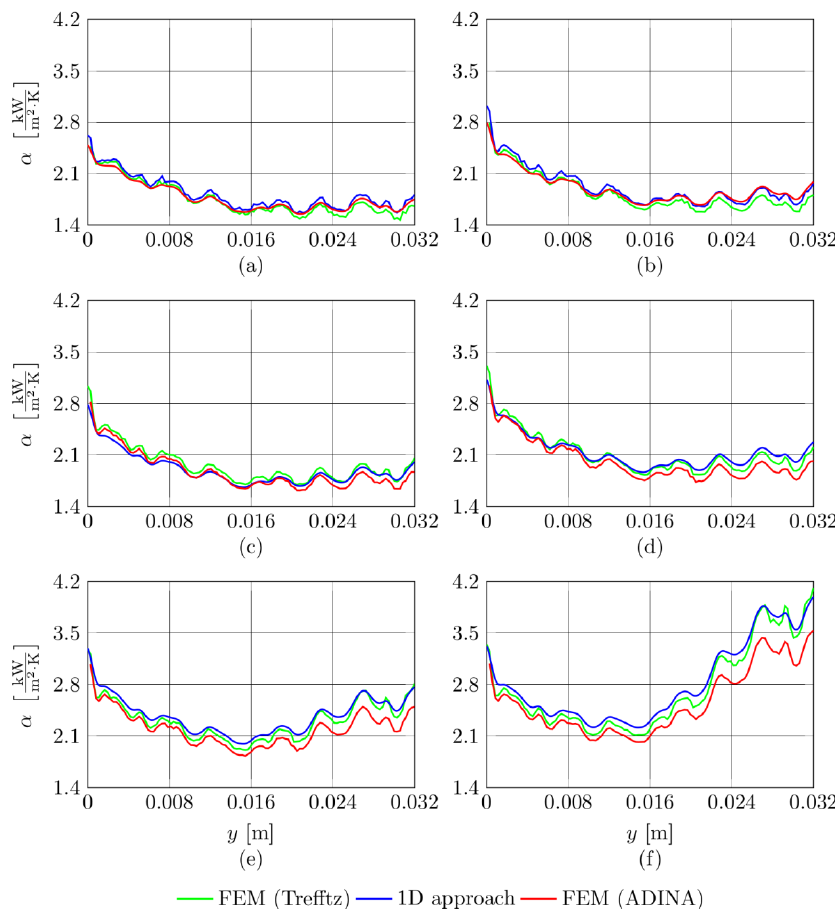
Figure 15. Heat transfer coefficient vs. the distance from the minichannel inlet determined from the FEM computations using the Trefftz functions (green line), ADINA software (red line) and according to the 1D approach (blue line); the test section with five minichannels; experimental parameters listed in Table 2; heat flux values: ( a ) q” = 13.8 kW / m 2 ; ( b ) q” = 24.6 kW / m 2 ; ( c ) q” = 31.3 kW / m 2 ; ( d ) q” = 38.7 kW / m 2 ; ( e ) q” = 47.2 kW / m 2 ; ( f ) q” = 55.8 kW / m 2 .